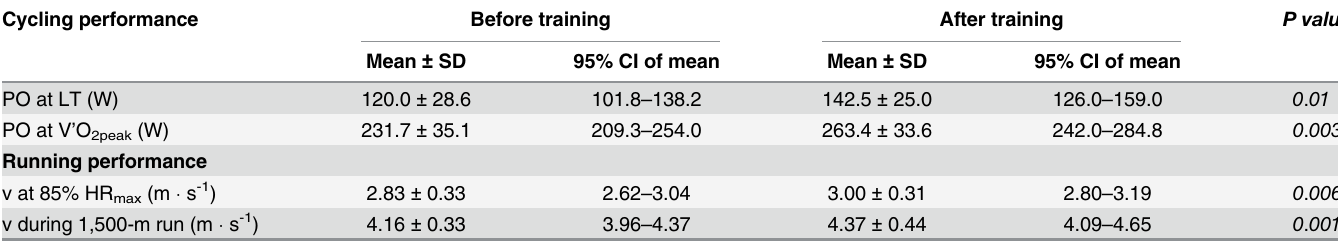
Table 2. Physical performance (cycling and running) before and after the 20 weeks of cycling endurance training. Cycling performance